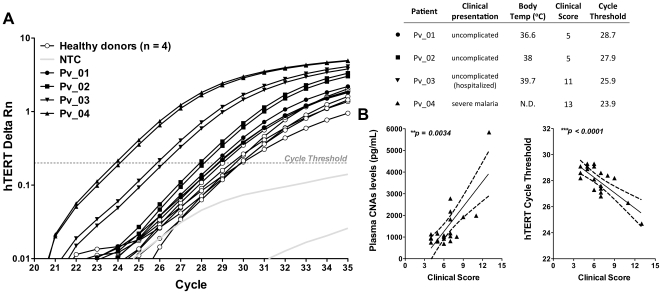
Plasma CNAs levels reliably correlate with the P. vivax clinical spectrum.CNAs levels were quantified in plasma from P. vivax patients with different clinical presentations. (A) Amplification of the genomic sequence of hTERT by qPCR in four healthy controls, and P. vivax patients (Pv_01 to 04) scored according to clinical/hematological parameters. Only four patients are shown for illustration purposes. (B) Correlation between the final clinical score of P. vivax patients (n = 21) and their plasma CNAs levels (pg/ml) (Spearman r = 0.6092, p = 0.0034), or their Ct for the amplification of the hTERT (Pearson r = −0.7897, p<0.0001).